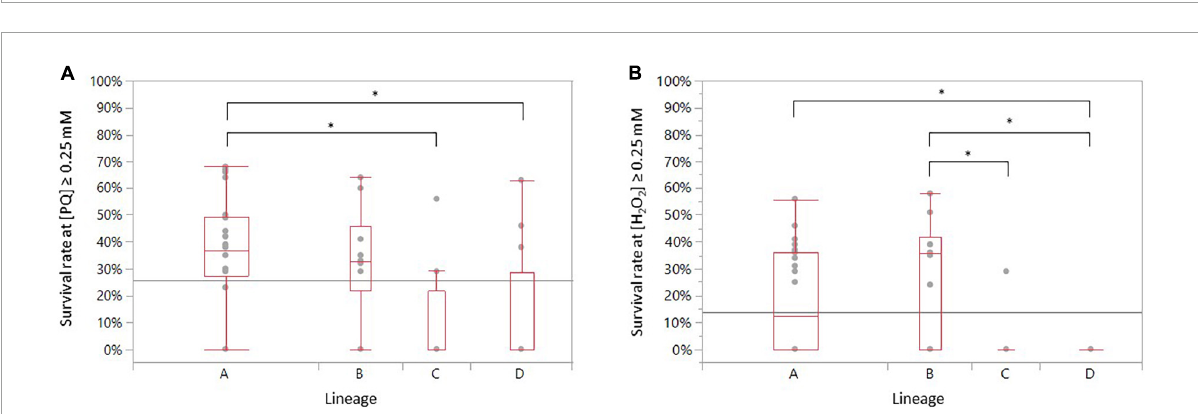
FIGURE5 Distribution of the survival rate of the 52 recurrent C. jejuni strains exposed to (A) PQ and to (B) H 2 O 2 according to their genomic lineage. Statistical significance was determined using the ANOVA test ( ∗ p ≤